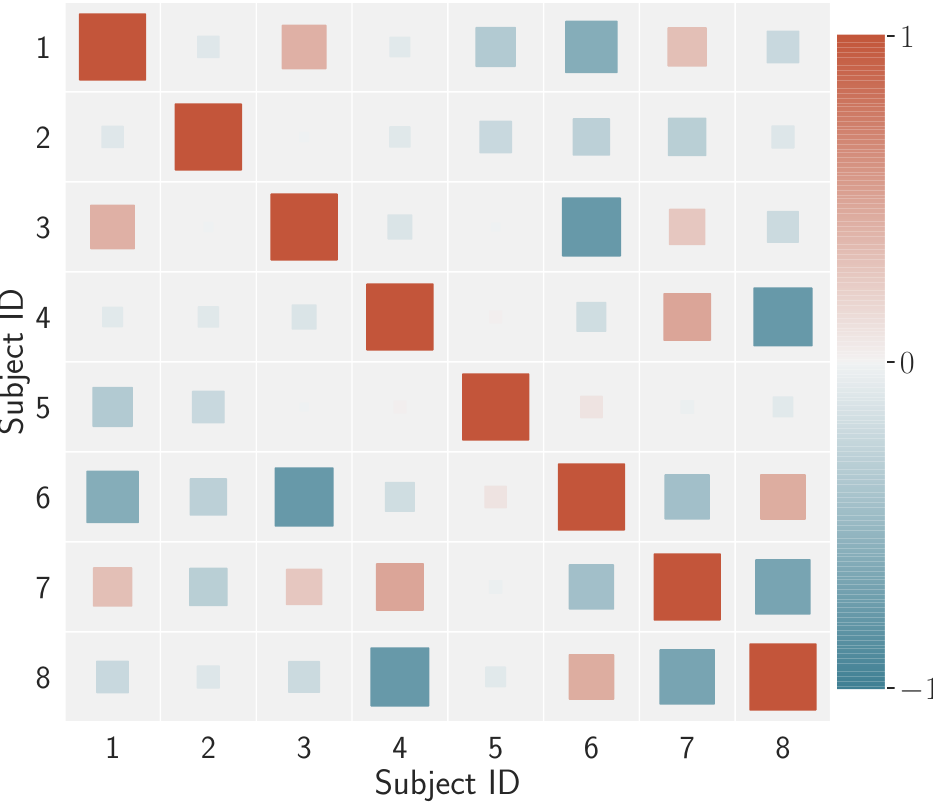
Figure 8. Hinton diagram for the correlation coefficients calculated over the average feature vectors of the subjects. The square size is proportional to the magnitude of the correlation; the colour denotes the degree of the correlation coefficient in the range depicted in the side